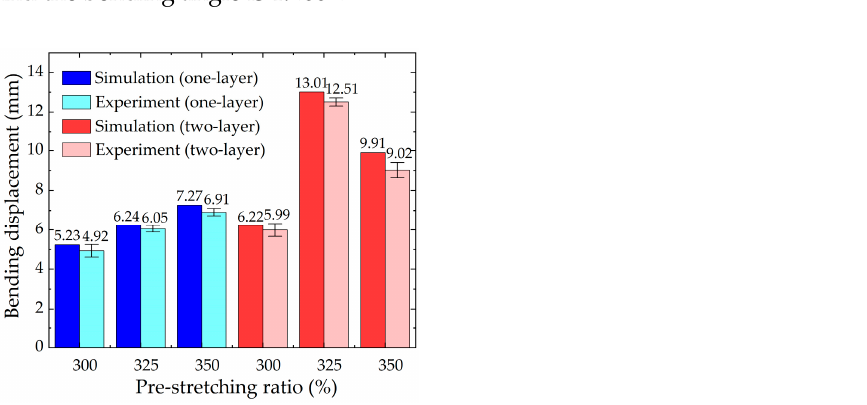
Figure 12. Numerical and experimental results of the soft finger with a one-layer DE membrane and a two-layer DE membrane, when the pre-stretching ratios are 300%, 325% and 350%, respec-